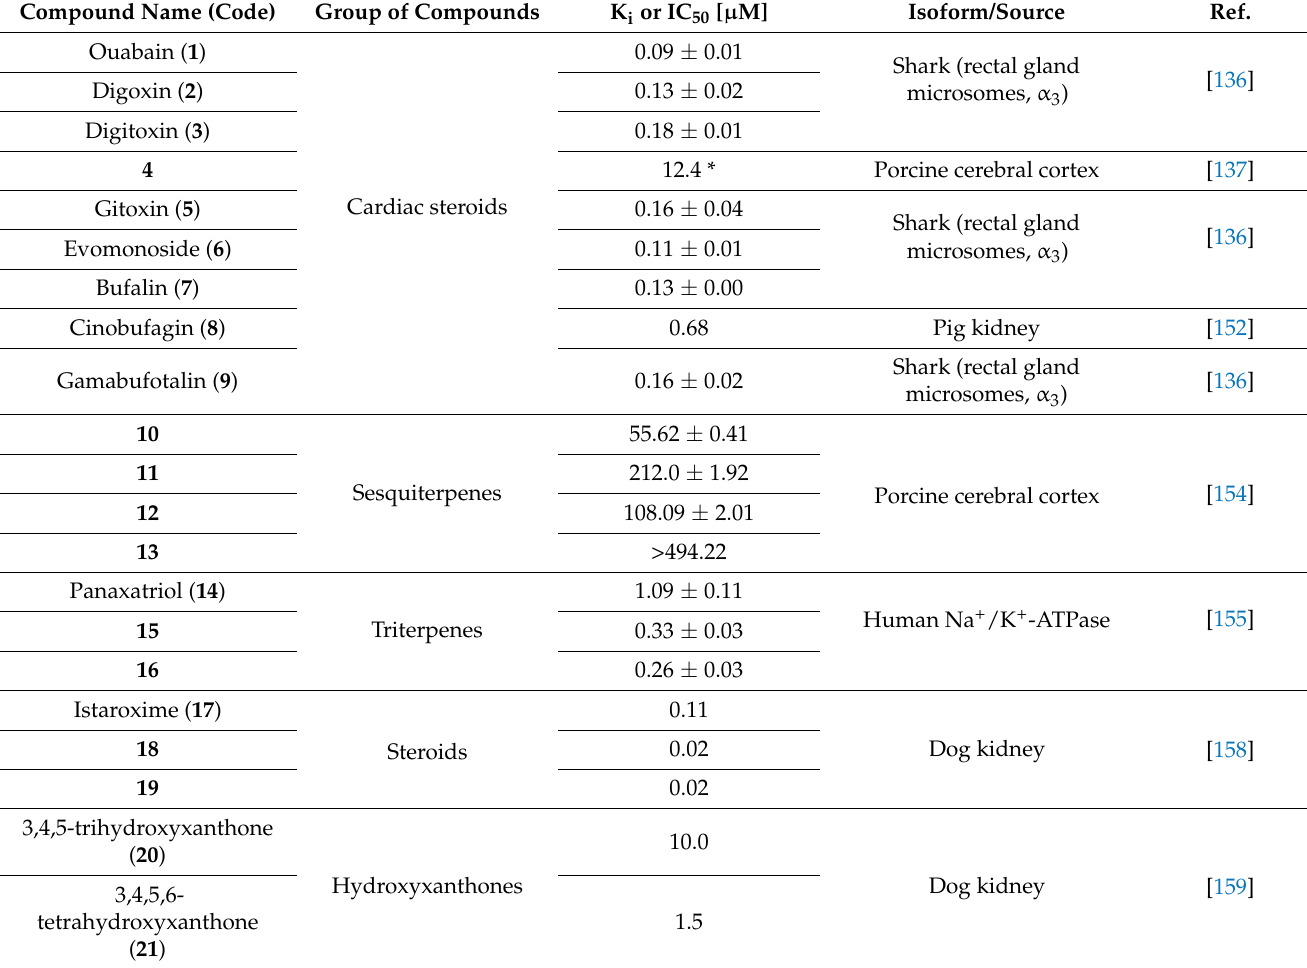
Table 3. Inhibitory constants (K i ) of selected Na + /K + -ATPase